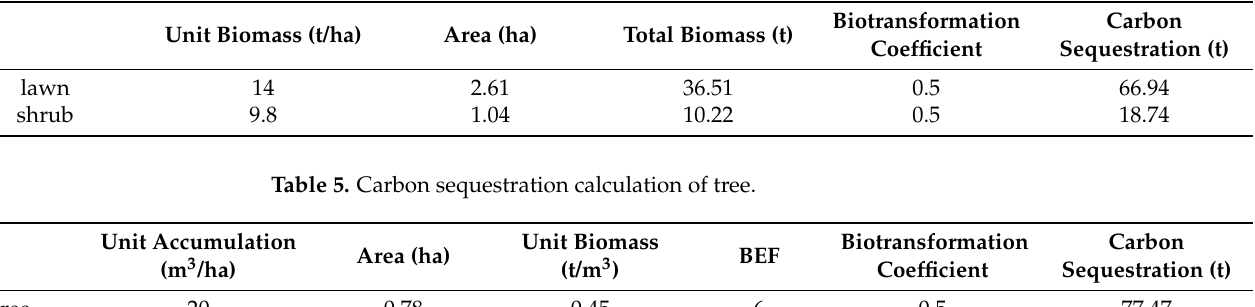
Table 4. Carbon sequestration calculation of lawn and shrub.